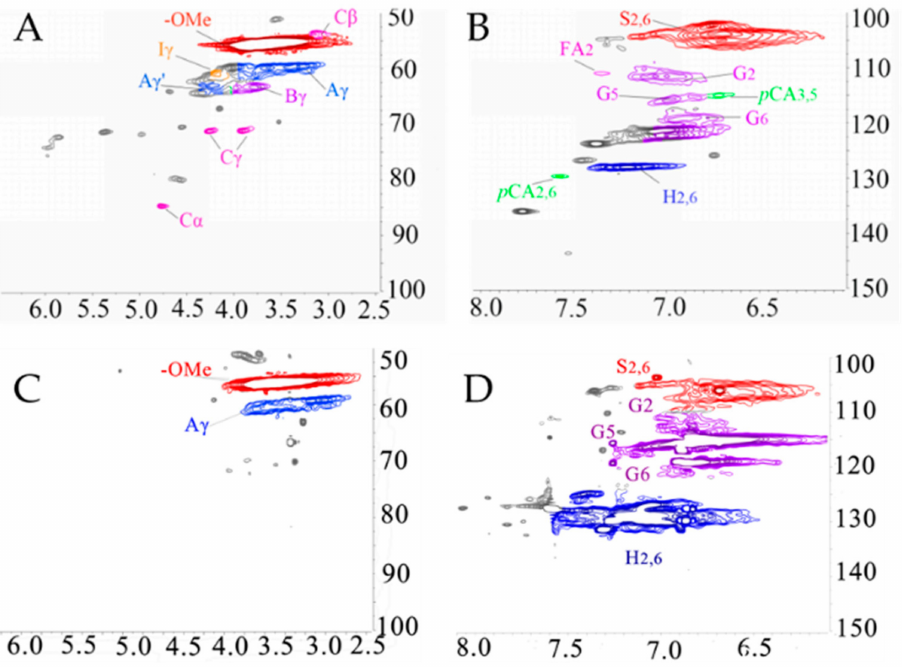
Figure 4. 2D HSQC NMR spectra: ( A ) oxygenated side region of KL, ( B ) aromatic region of KL, ( C ) oxygenated side region of PKL, ( D ) aromatic region of